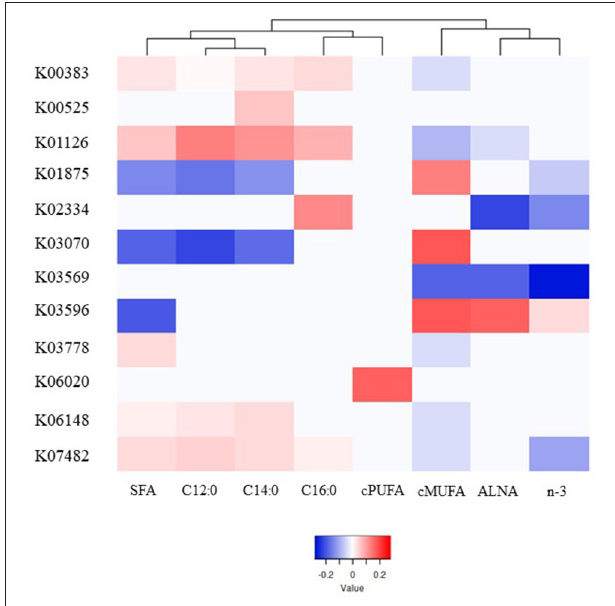
FIGURE 3 | Heatmap of the most significant microbial genes indicating their partial least square coefficient for each fatty acid. Blue color indicates a negative PLS coefficient between the genus and the fatty acid, whilst red color indicates the